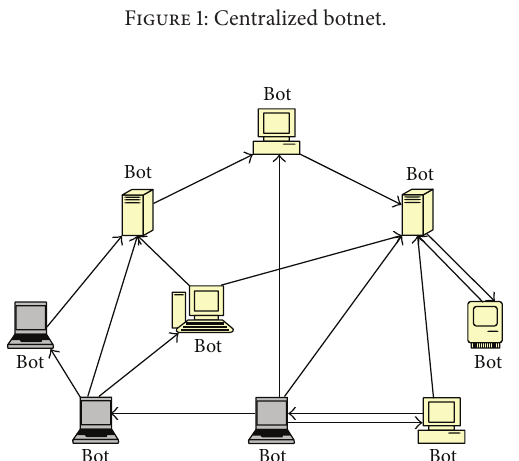
Figure 1: Centralized botnet.